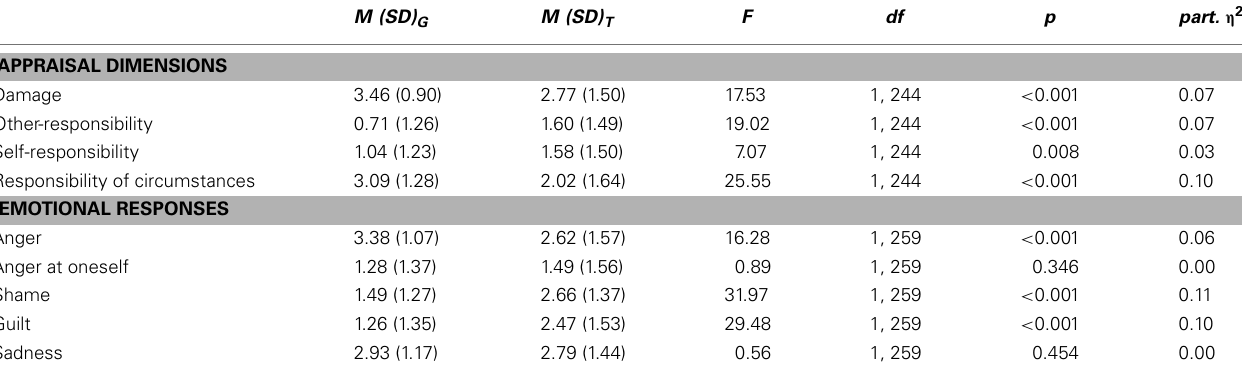
Table 4 | Univariate effects of (a) appraisal dimensions and (b) emotional responses for the circumstances-caused scenario